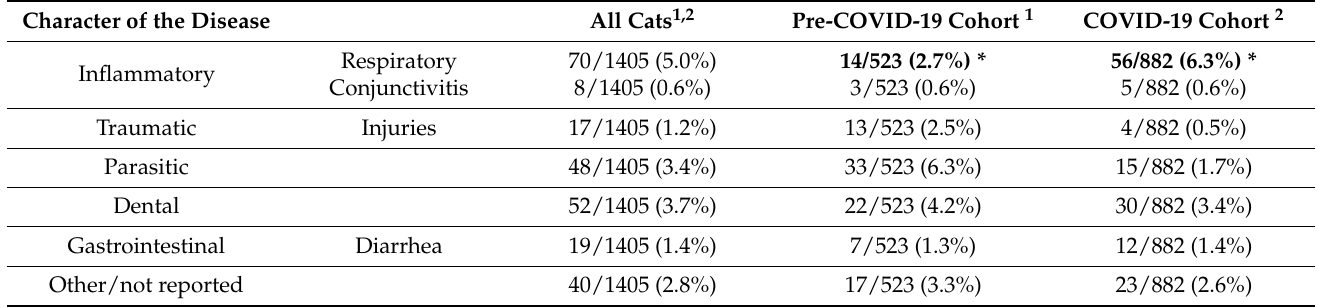
Table 2. Reported clinical signs in the sick-rated cats of both cohorts from February 2019 to August